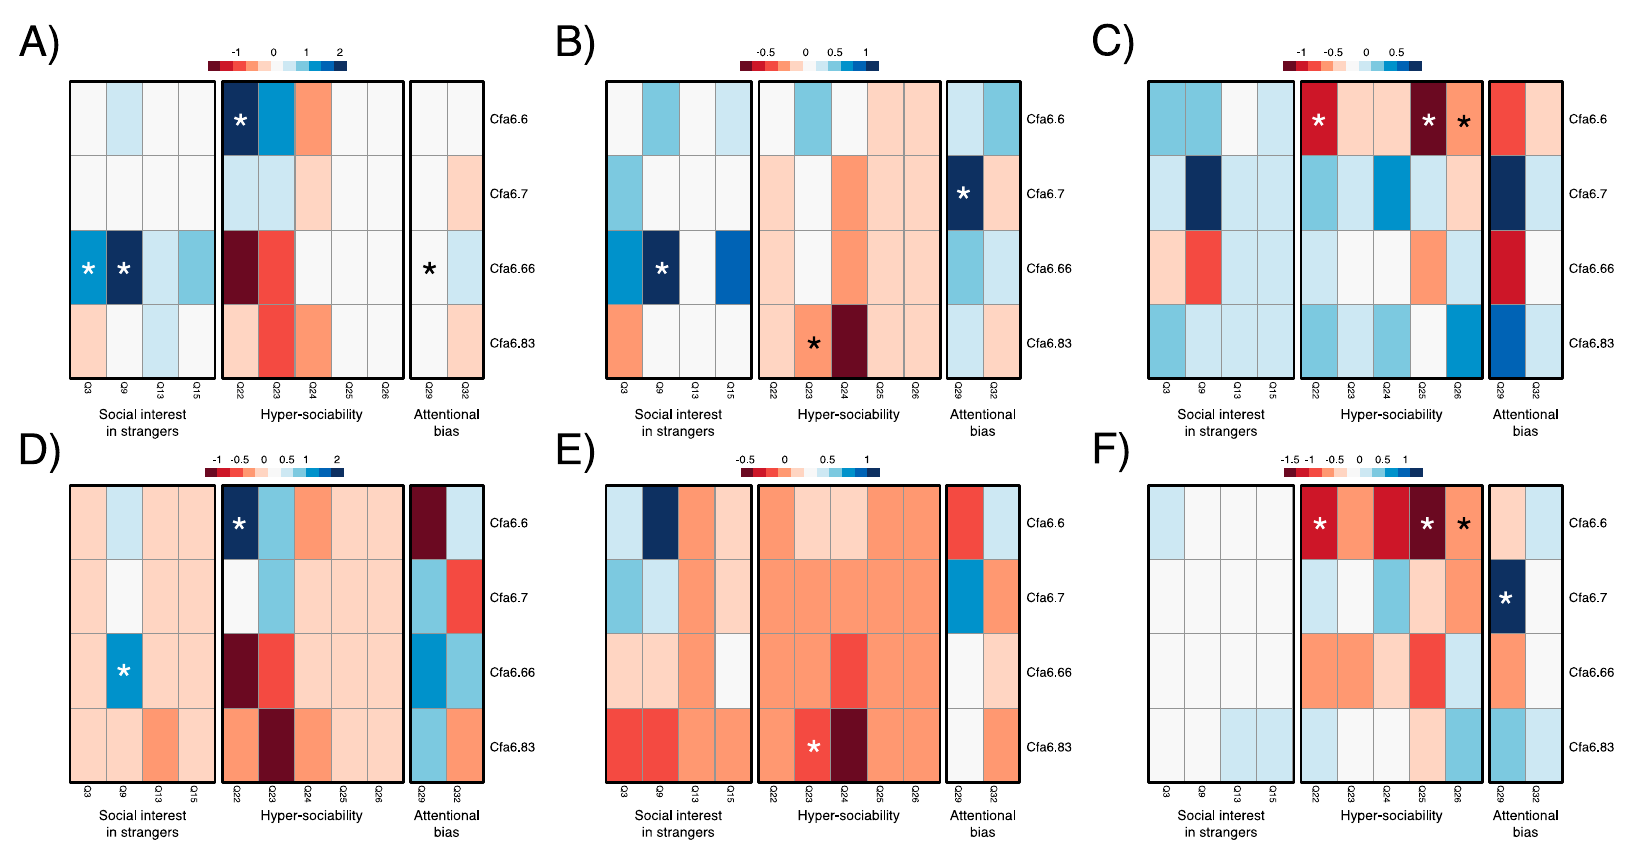
Figure 2. Heat map depicting beta values for associations between Cfa6.6, Cfa6.7, Cfa6.66, and Cfa6.83 MEI copy number and C-BARQ © scores assessing lower social interest in strangers (Q3, Q9, Q13, Q15), higher hypersociability (Q22, Q23, Q24, Q25, Q26), and lower attentional bias (Q29 and Q32) for ( A ) all dogs of 1–5 years of age ( n = 117); ( B ) pet dogs of 1–5 years of age ( n = 69); ( C ) pet dogs >5 years of age ( n = 95); ( D ) all dogs owned for >1–5 years ( n = 115); ( E ) pet dogs owned from 1–5 years ( n = 65); and ( F ) pet dogs owned > 5 years ( n = 96). Significant beta values ( p < 0.05) are marked with an asterisk (*). See Table S2 for more details on each insertion. C-BARQ©: Canine Behavioral Assessment Research Questionnaire; MEI: mobile element insertion.